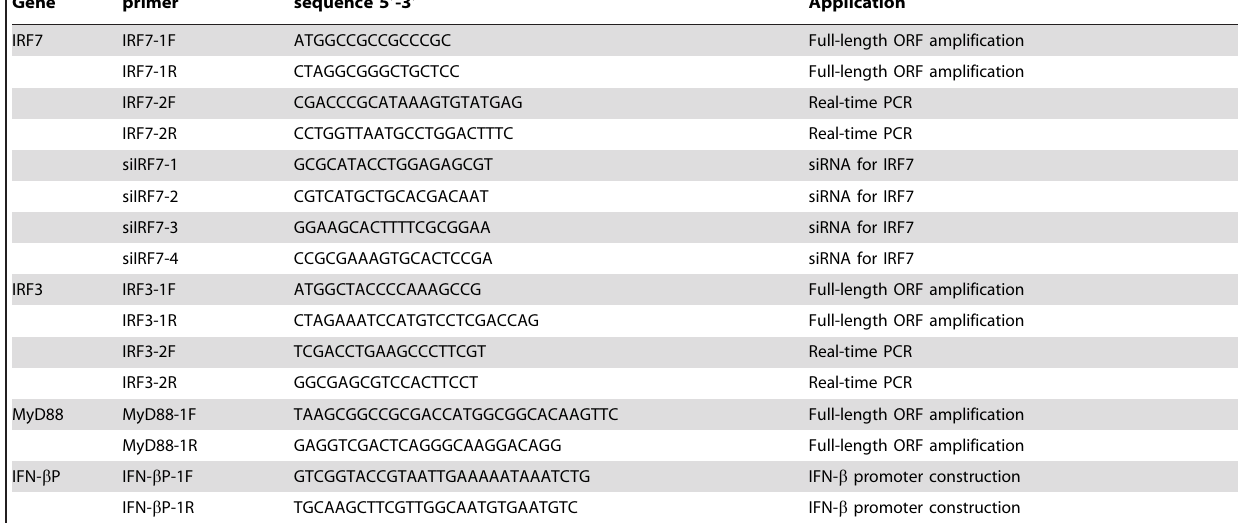
Luciferase promoter